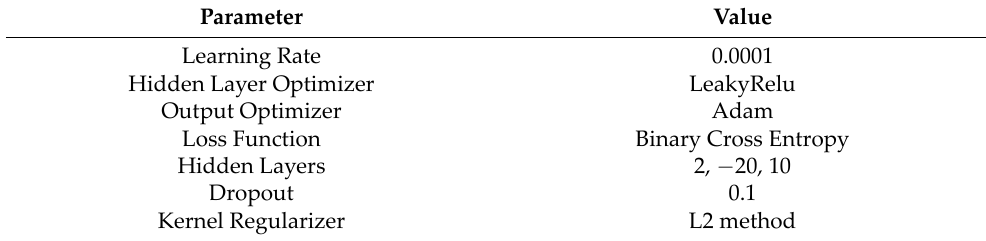
Table 5. K‑CGAN Discriminator Neural Network Hyperparameter Settings.